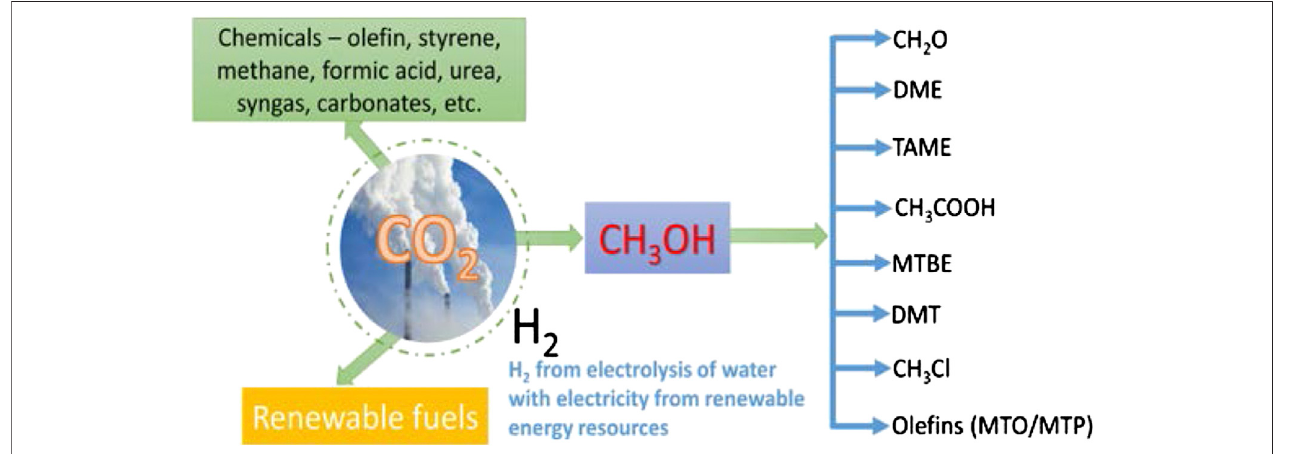
FIGURE 1 | Diverse products from thermochemical CO 2 conversion and